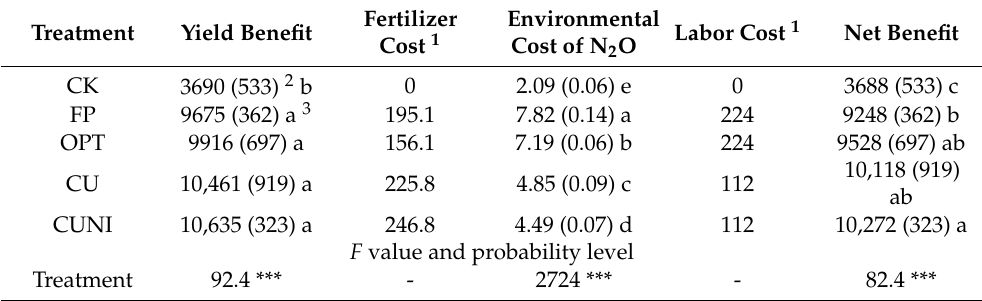
Table 3. The average benefits of lettuce yield (USD ha –1 ) and costs of purchasing N fertilizers, under different treatments during